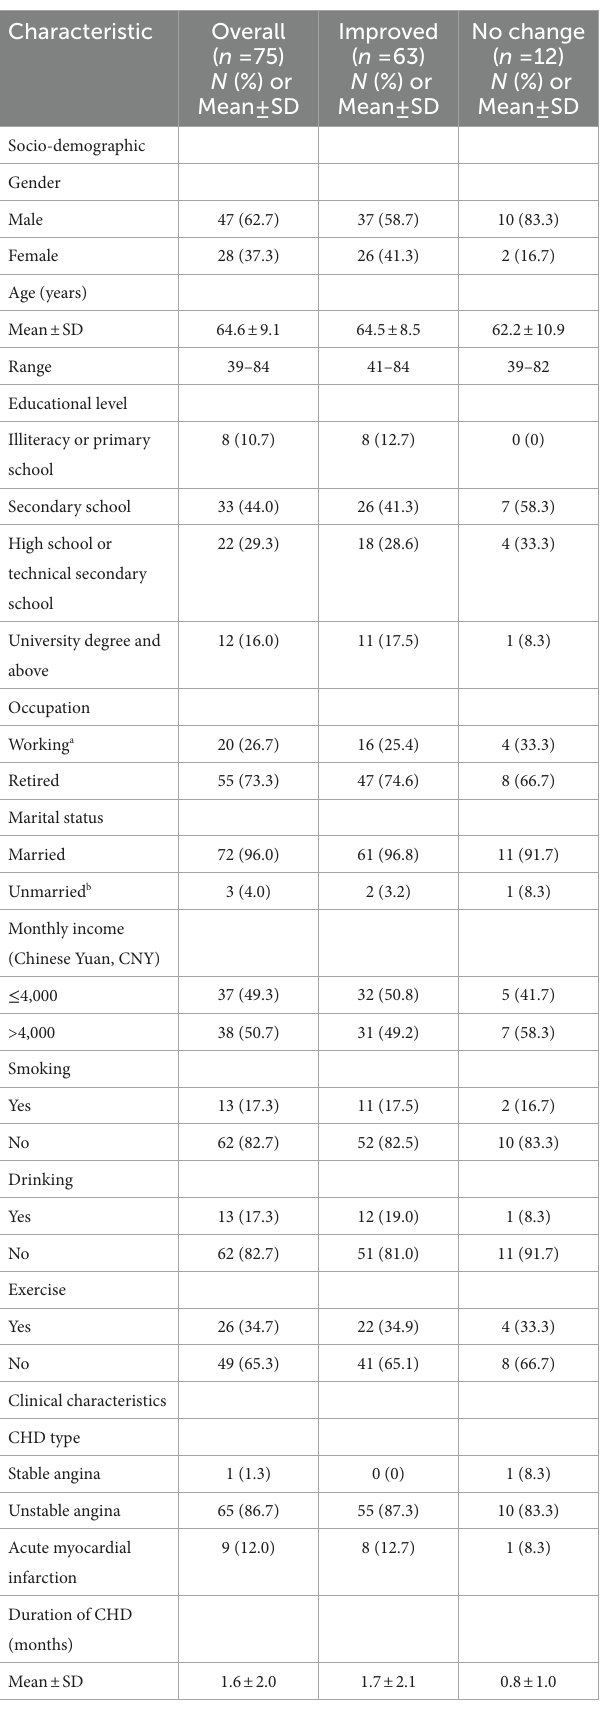
TABLE 1 Socio-demographic and clinical characteristics of CHD patients.